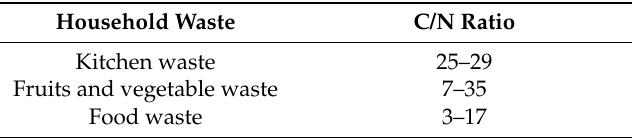
Table 2. C/N ratio of familiar biodegradable